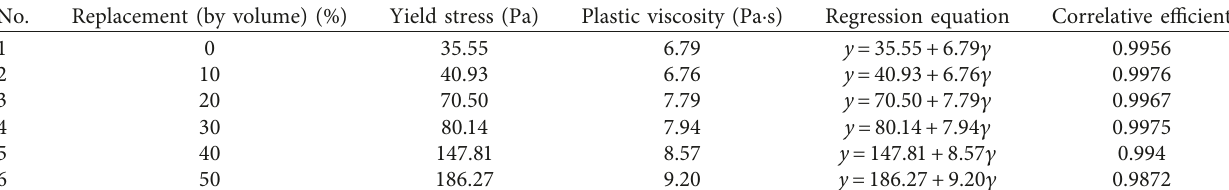
Table 3: Rheological parameters of mortar pastes.